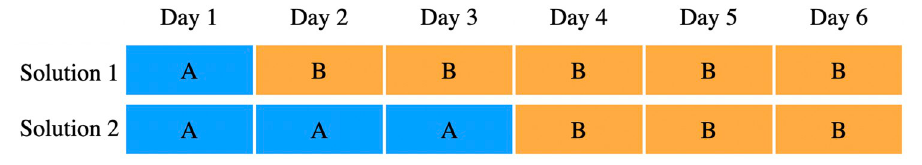
Fig 1. Example of two distinct solutions with the same continuity of care for one patient over 6